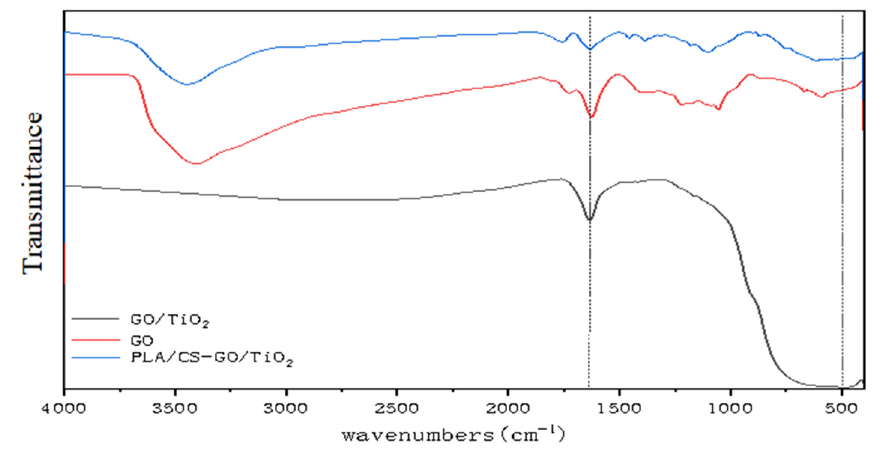
Figure 6. FTIR spectra of GO, GO/TiO 2 , and PLLA/CS–GO/TiO 2 .